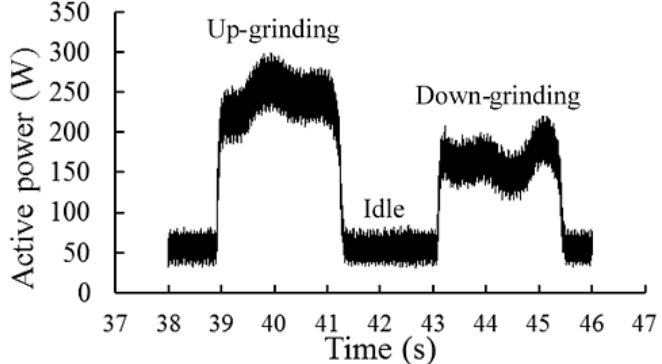
Figure 3. Signal of active power consumption by the electric motor.